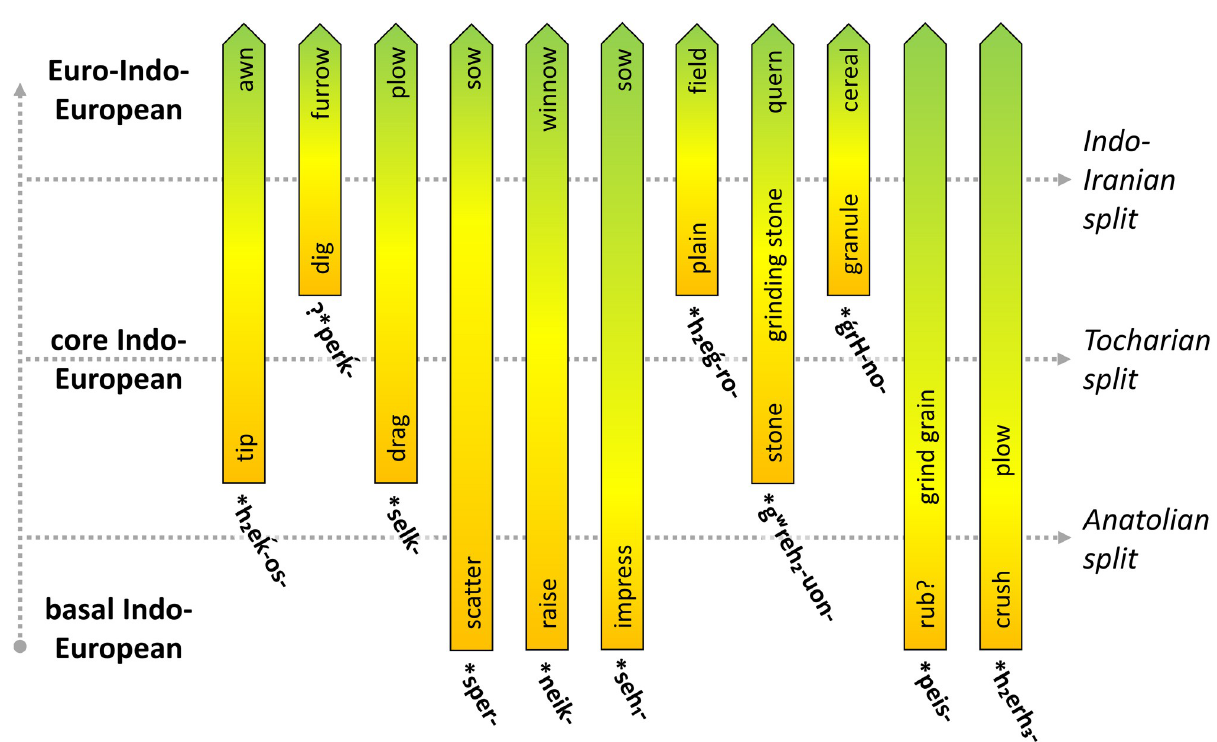
Fig 2. The emergence of cereal cultivation and processing terminology between Indo-Anatolian and the fragmenting core Indo-European dialect continuum. The reconstructed protoforms of some agricultural terms are placed in the figure to indicate in which phase of the Indo-European language family they emerged. The accompanying arrows show the evolution of the meanings of these protoforms through